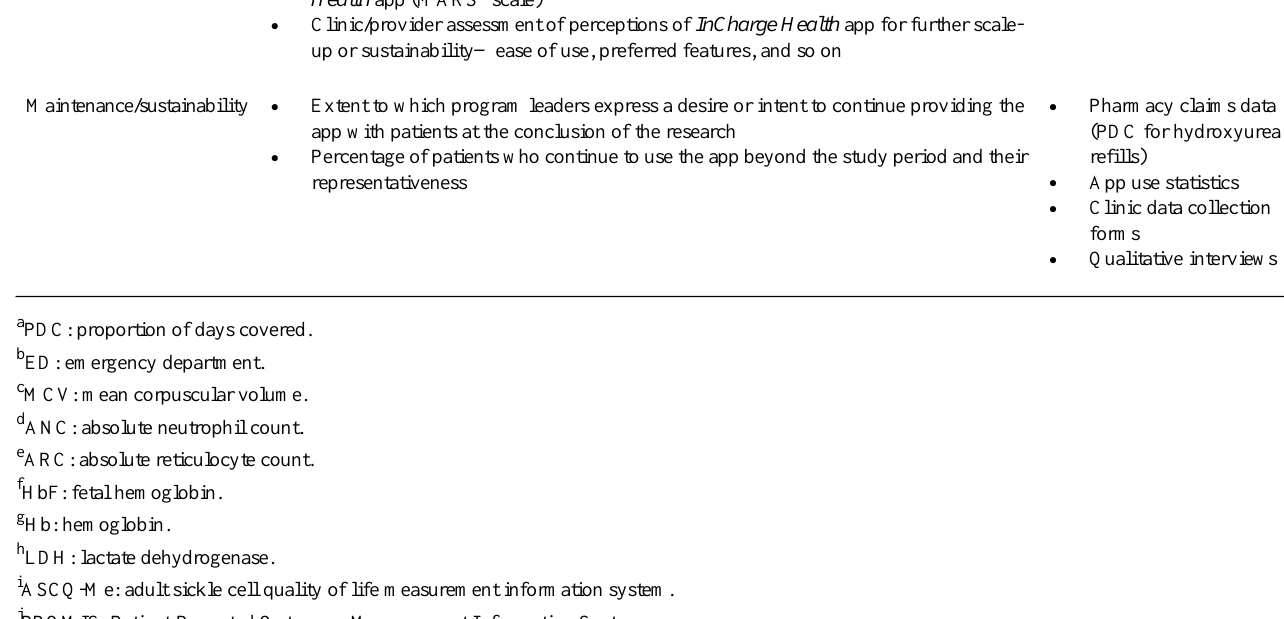
MARS: mobile app rating